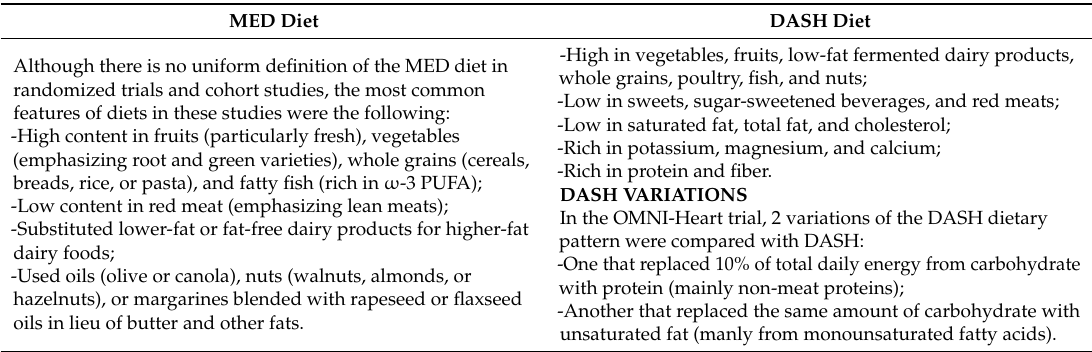
Table 1. MED diet and DASH diet composition